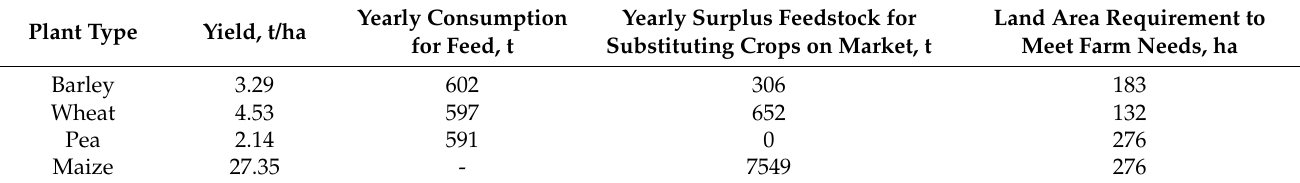
Table 3. Land area requirement for rearing 1000 pigs on a